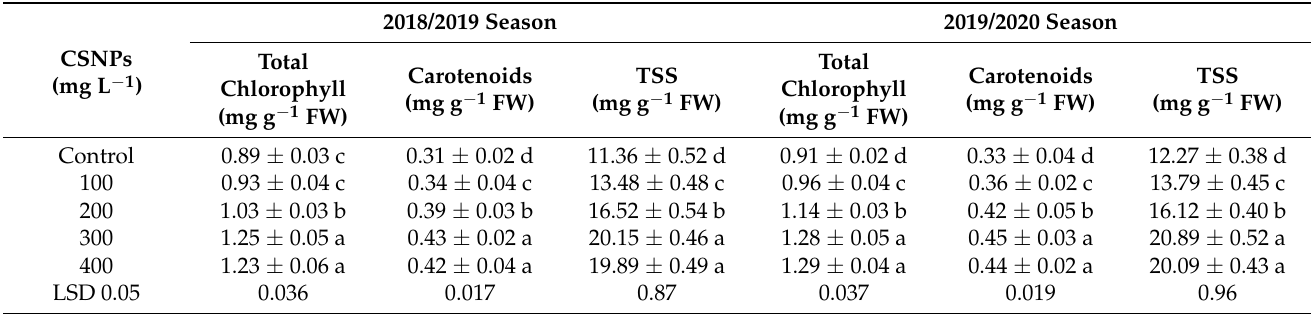
Table 2. Impact of chitosan nanoparticles (CSNPs) on chlorophyll, carotenoids and total soluble sugars (TSS) of Matricaria chamomilla in the two experimental seasons. Data are means ± SE ( n = 3). In each column, least significant difference was calculated and letters represent the statistical differences among treatments at p ≤